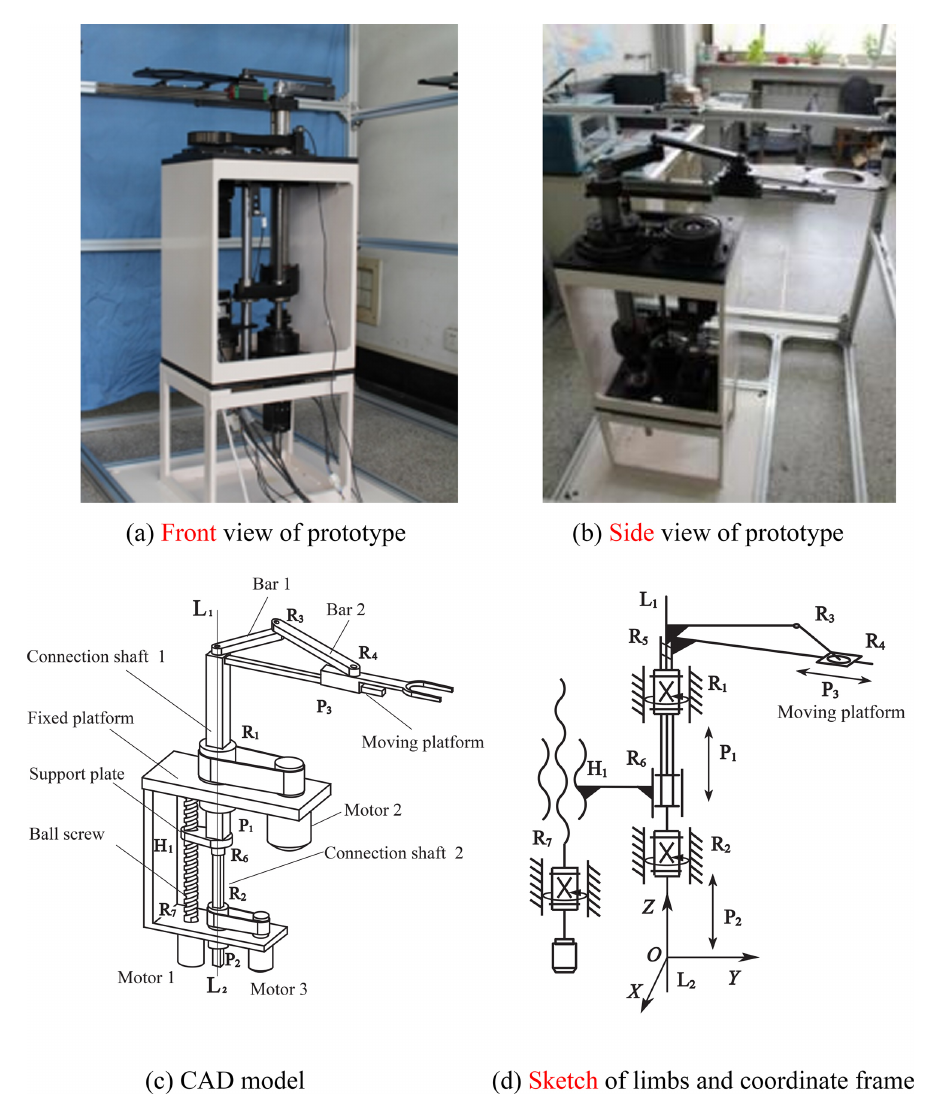
Figure 1. The 3-DoF PM with limbs of embedding